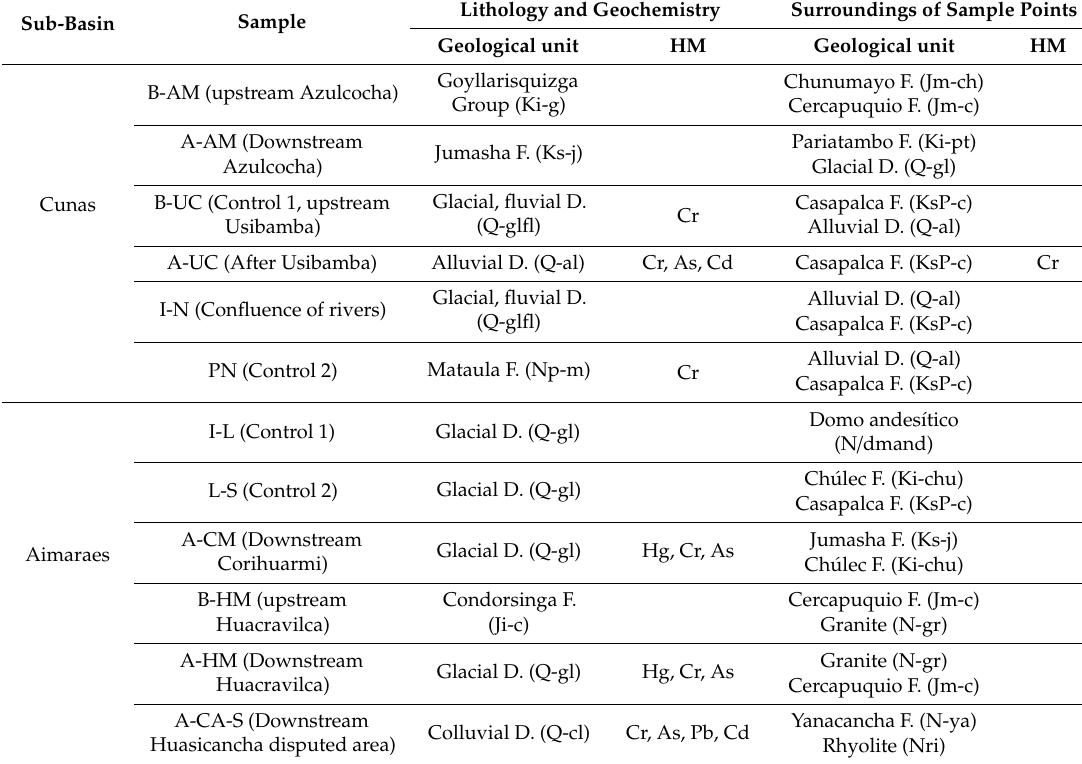
Table 2. Geological characteristics and natural heavy metals (HM) presence in water sample points and their